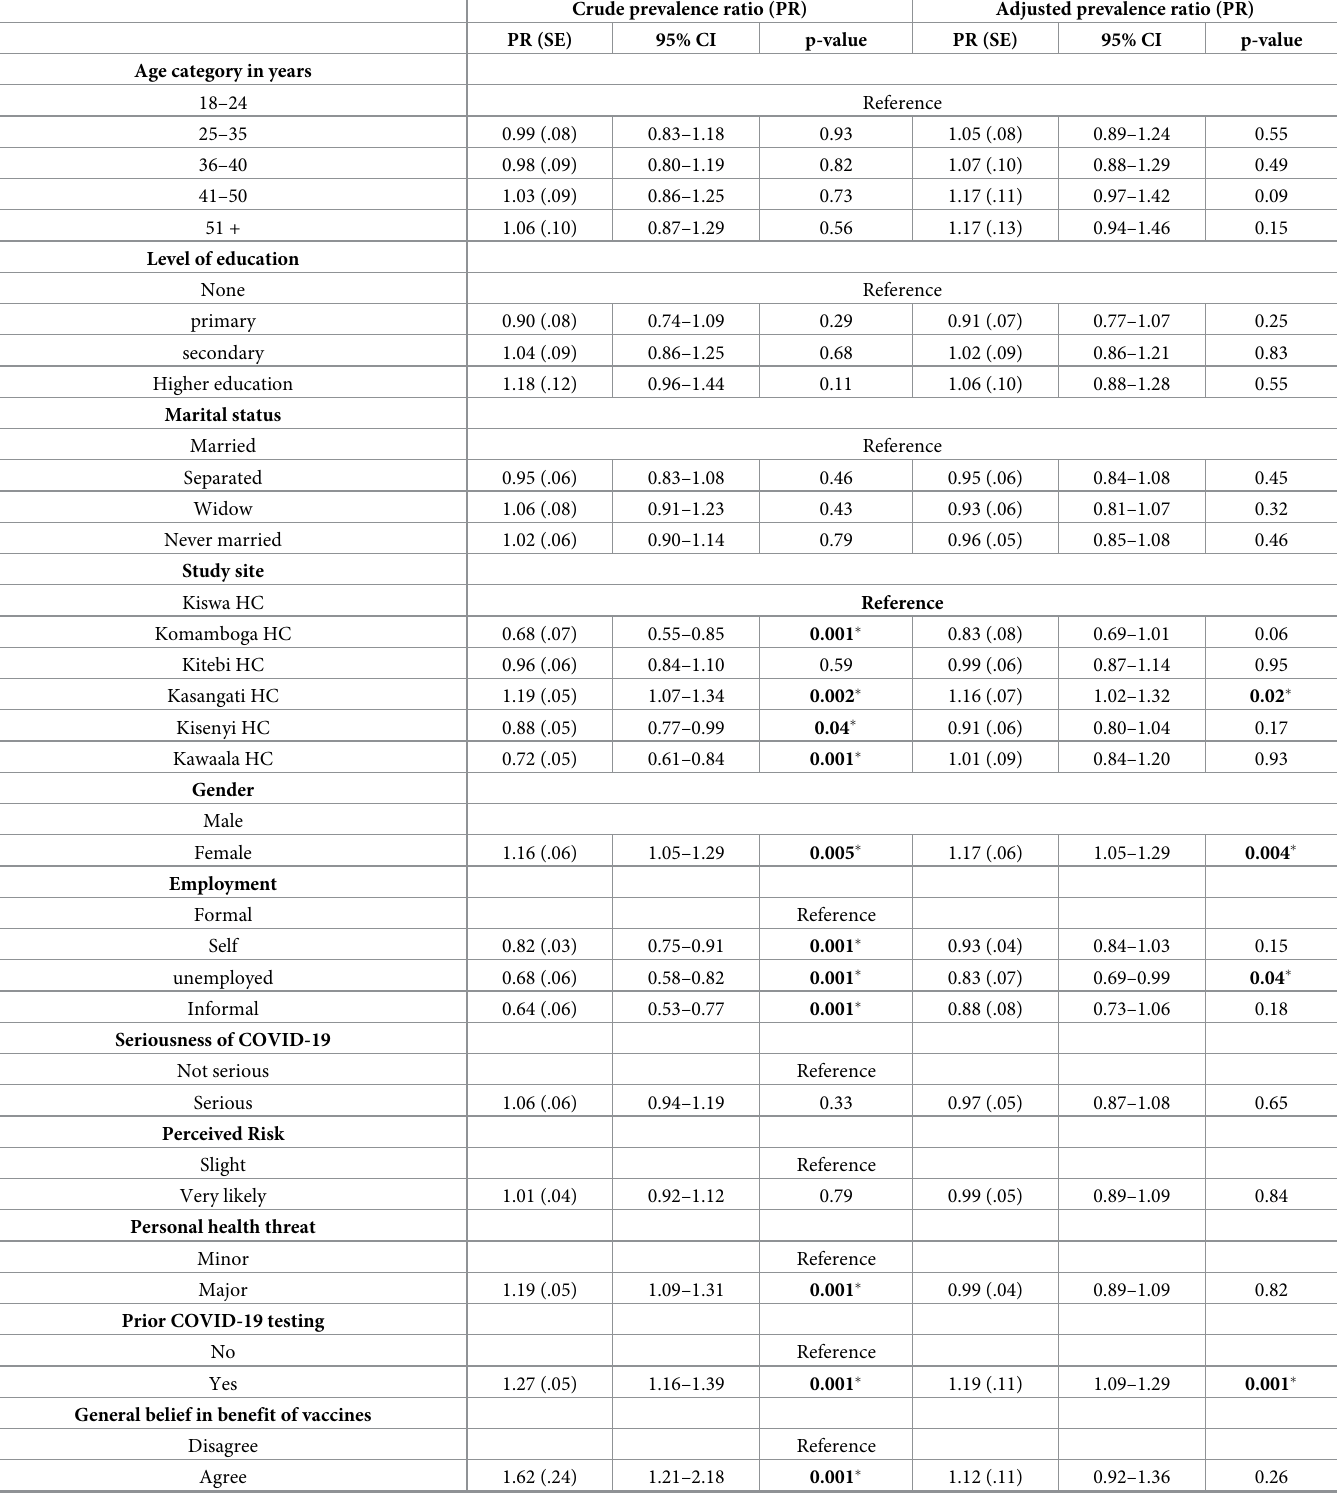
Table 6. Modified Poisson regression multivariable model for association of COVID-19 vaccination